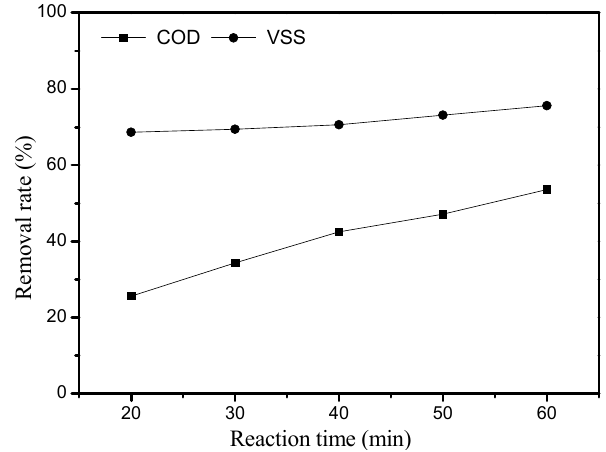
Figure 4. Effect of reaction time on the COD and VSS removal rates (Temp.: 220 °C; Catalyst: 0.5 g; Oxygen dosage: 1.0 MPa).